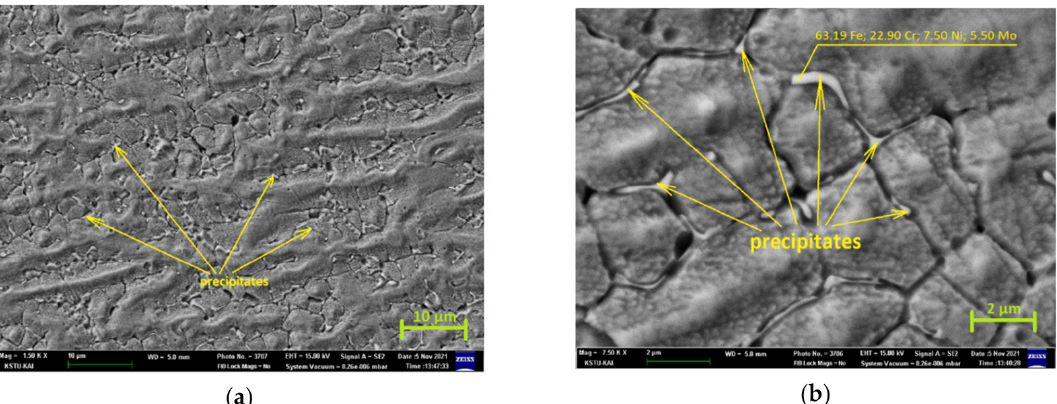
Figure 13. Microstructure of the middle of the second pass of the HT sample, magnification ( a ) 1500 and ( b )